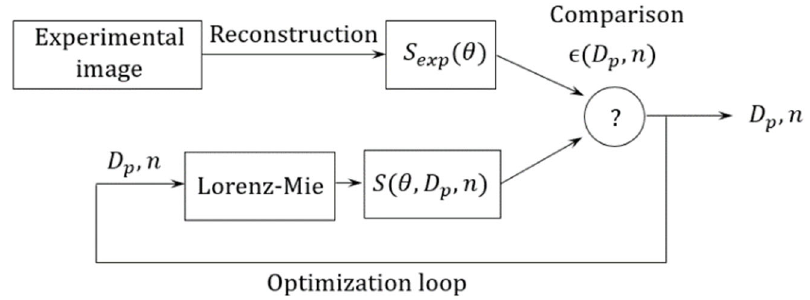
Figure 5. Schematic of the optimization procedure used for particle characterization.